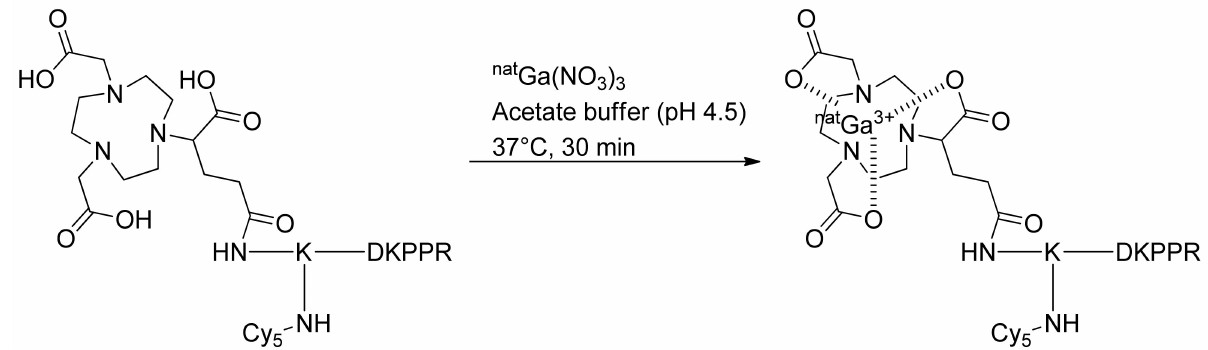
Figure 2. Complexation of NODAGA-K(Cy5)DKPPR with nonradioactive gallium-69.